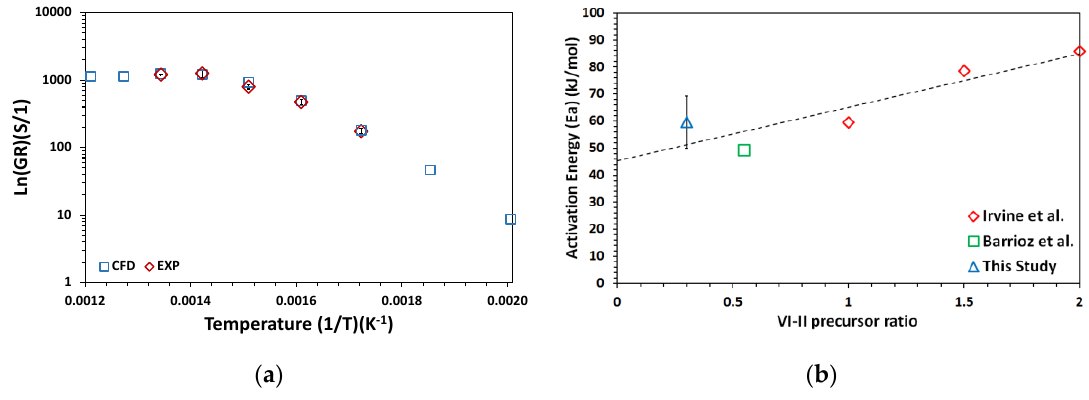
Figure 8. Using the S-1 configuration for the chamberless coating head during the deposition of CdTe,